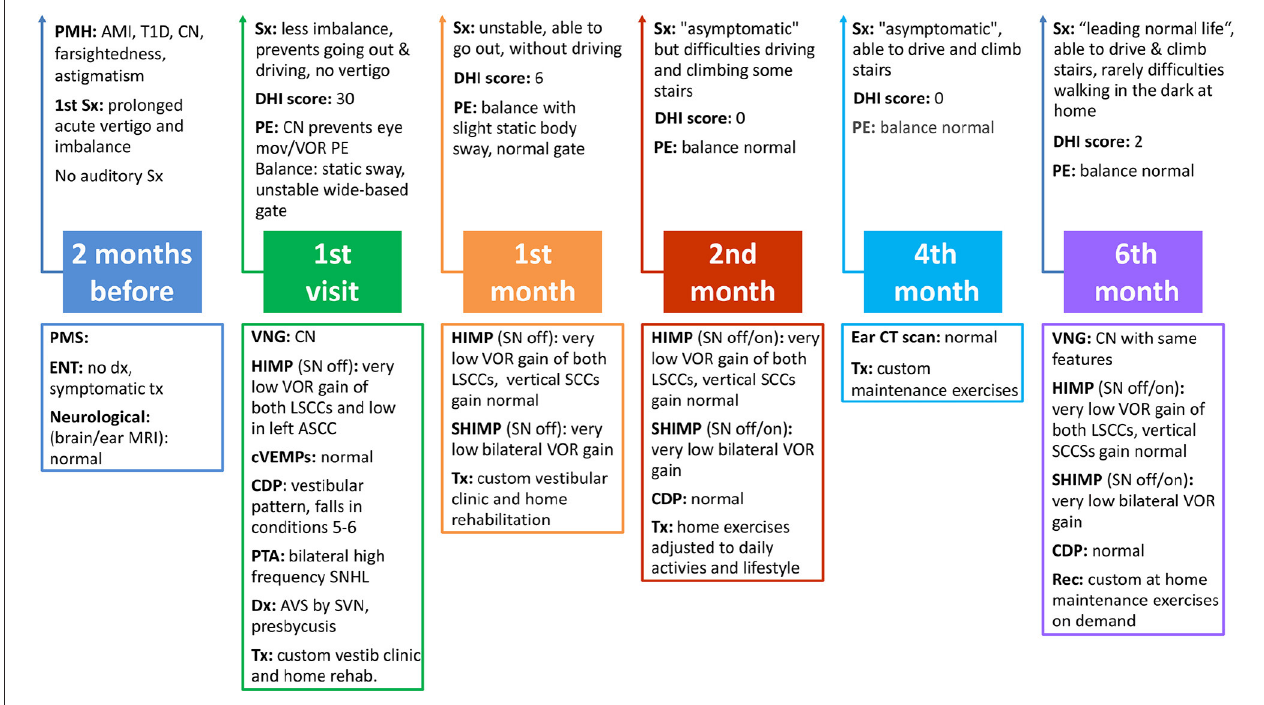
FIGURE 2 | Timetable including the clinical information obtained during patient visits. PMH, past medical history; AMI, acute miocardial infarction; T1D, type 1 diabetes; CN, congenital nystagmus; Sx, symptoms; Dx, diagnosis; PMS, previous medical studies; N, normal; Tx, treatment; PE, physical examination; SN off, HIMP/SHIMP protocol performed without selecting the check box “Spontaneous nystagmus”; SN on, HIMP/SHIMP protocol performed selecting the check box “Spontaneous nystagmus”; LSCCs, lateral semicircular canals (SCCs); ASCC, anterior SCC; CDP, computerized dynamic posturography; Rec,